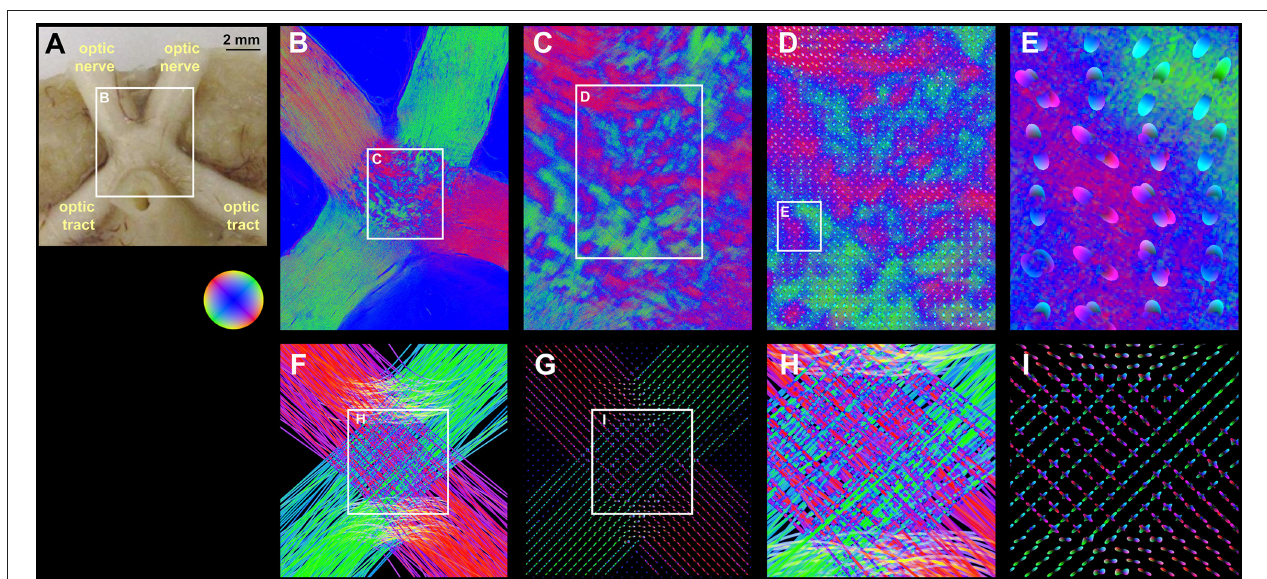
FIGURE 5 | Real and simulated brain section from the hooded seal. (A) Blockface image of the optic chiasm of the hooded seal before sectioning. (B) Fiber orientation map of a medial section through the optic chiasm. Optic nerves and optic tracts appear as massive and rather homogeneous fiber bundles. Most fiber tracts from the optic nerves decussate to the contralateral optic tract. (C) The decussation zone in the center (i.e., the chiasm) is characterized by a patch pattern produced by small fiber tracts (red and green color; exemplary orientations are indicated by black lines) and fiber crossings characterized by signal attenuation (blue color; exemplary highlighted by white arrow). Based on this FOM, pliODFs were created for super-voxel dimensions of 40 × 40 × 1 native voxels. (D,E) demonstrate different enlargements of the field of pliODFs overlaid with the input FOM. (F) FOM of a simulated section through the optic chiasm and (G) corresponding pliODFs for super-voxel dimensions of 40 × 40 × 1 native voxels. (H) Zoom into the FOM of the fiber decussation zone and (I) corresponding pliODFs. The effects of crossing and bending fibers on the ODF shapes are